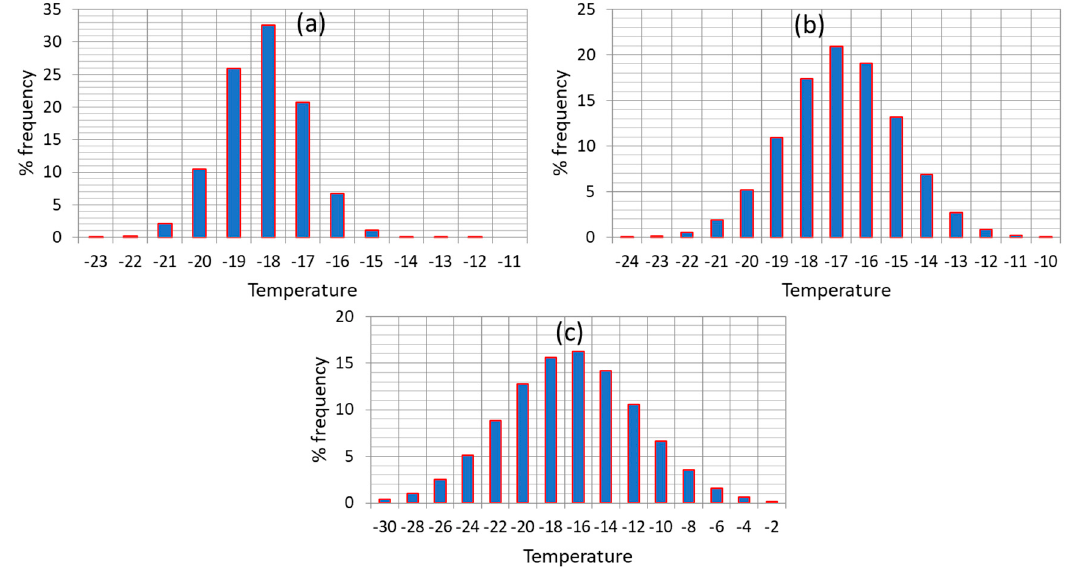
Figure 1. Temperature distribution during ( a ) production/distribution warehouse, ( b ) retail display and ( c ) domestic storage for frozen foods handling (FRISBEE